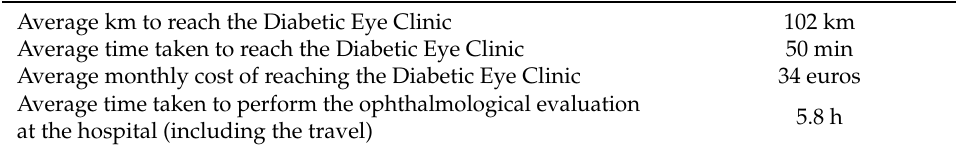
Table 5. Distance to reach the clinic and time spent to treat diabetic